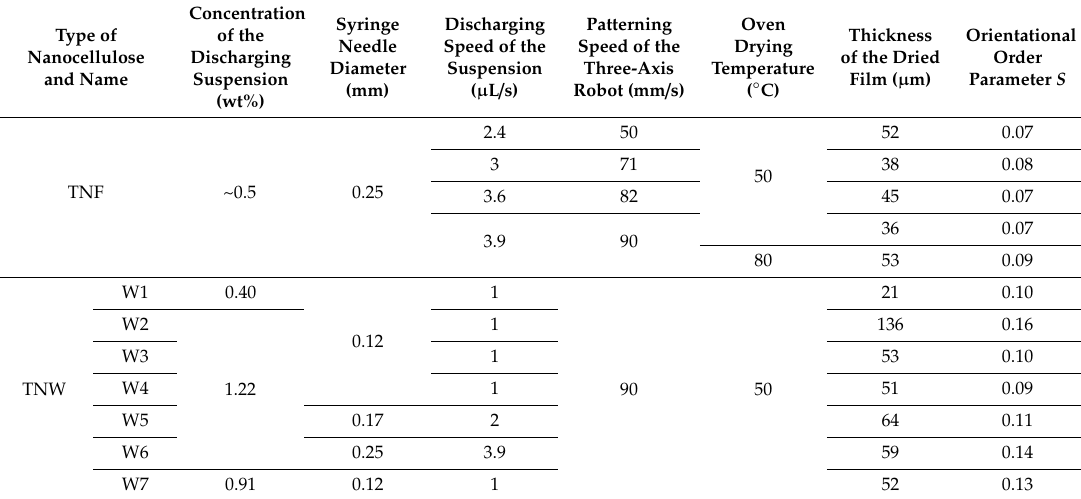
Table 1. Results of liquid-phase 3D patterning of